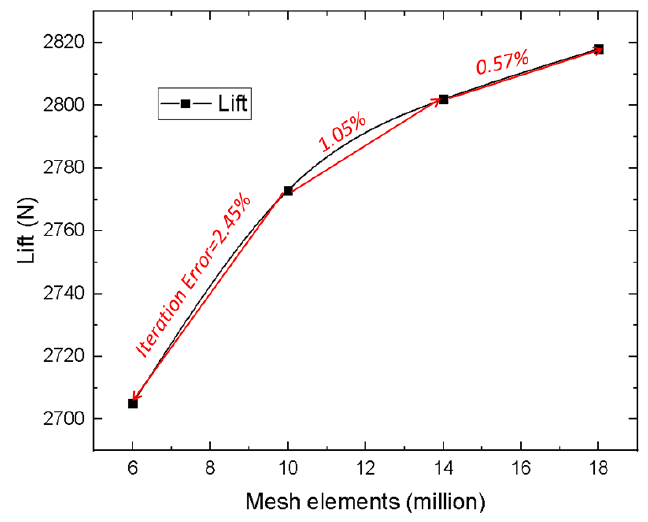
Figure 4. Lift of DCP with different heights of the first boundary layer. To study the effect of grid density on the calculation results, the grids are deliberately refined in the dynamic domains enclosing the propellers and the static domain enclosing the duct. The total number of grid cells is 6 million, 10 million, 14 million, and 18 million. The total lift of the DCP in hovering is calculated when the speed of both the upper and lower propellers is at 2500 RPM, and the results are shown in Figure 5. Considering the accuracy and economy of the calculation, 14 million cells were chosen to calculate the aerodynamic performance of the model in hovering.